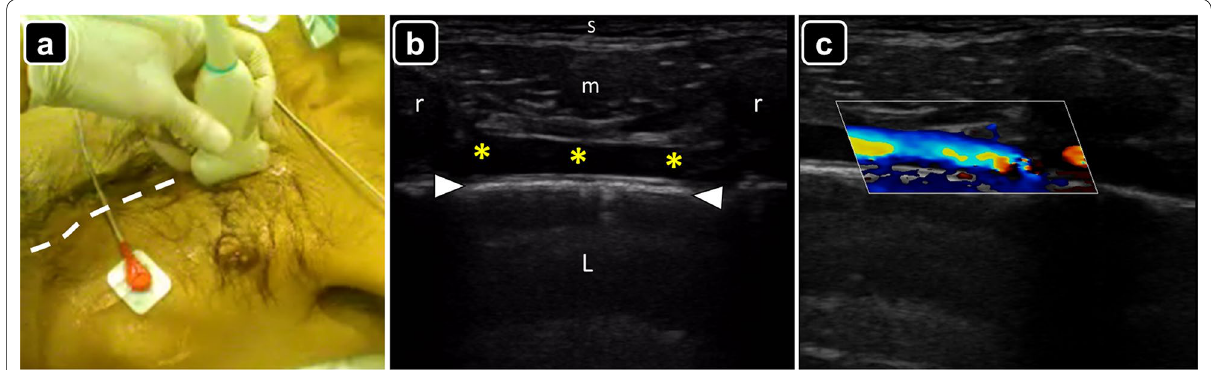
Fig. 3 a Technique for localization of the internal thoracic vessels (dotted line) using a linear probe along the left parasternal line. b Identification of the internal thoracic vessels (asterisks) on ultrasound; s skin and subcutaneous tissue; r ribs; arrowheads pleural line; L lung. c Color Doppler showing blood flow in the internal thoracic